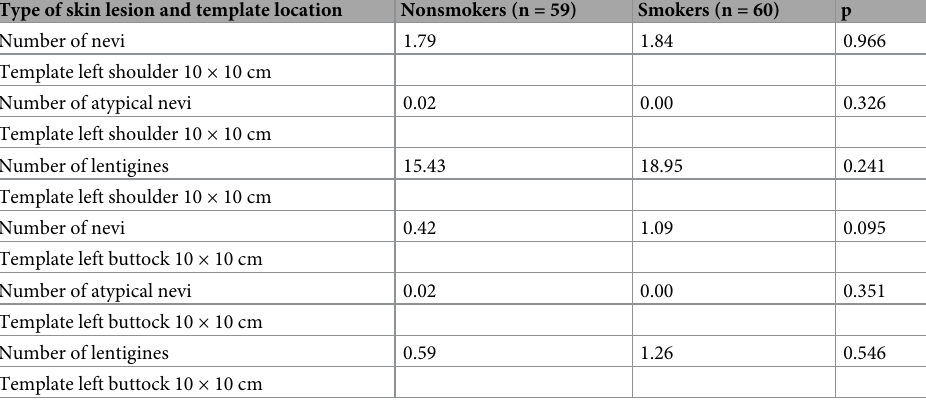
Table 5. Mean numbers of nevi and lentigines on the shoulder and